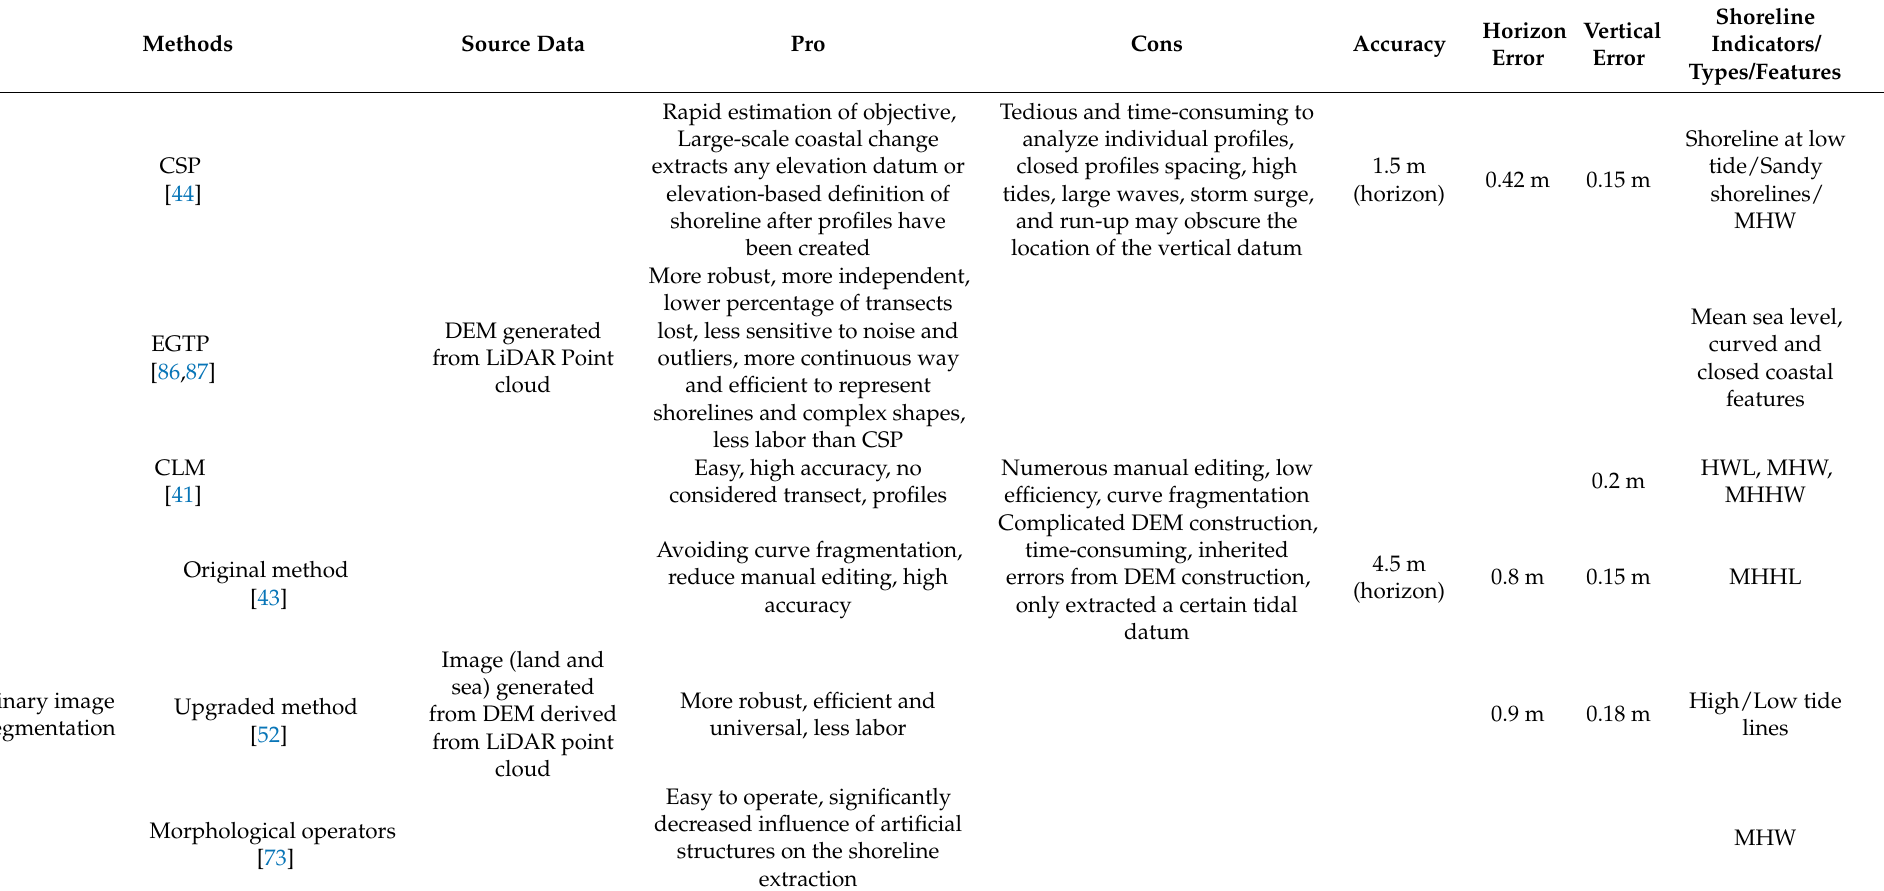
Table 5. Compared the representative method of shoreline